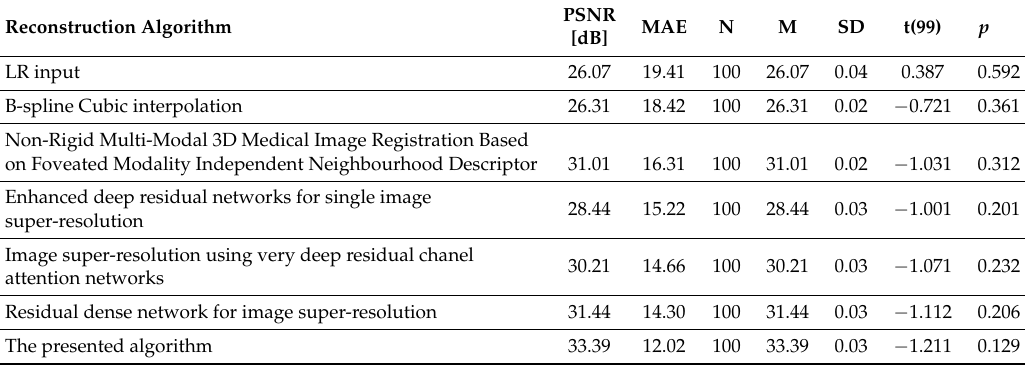
Table 4. Statistical parameters of the model performance metrics for Figure